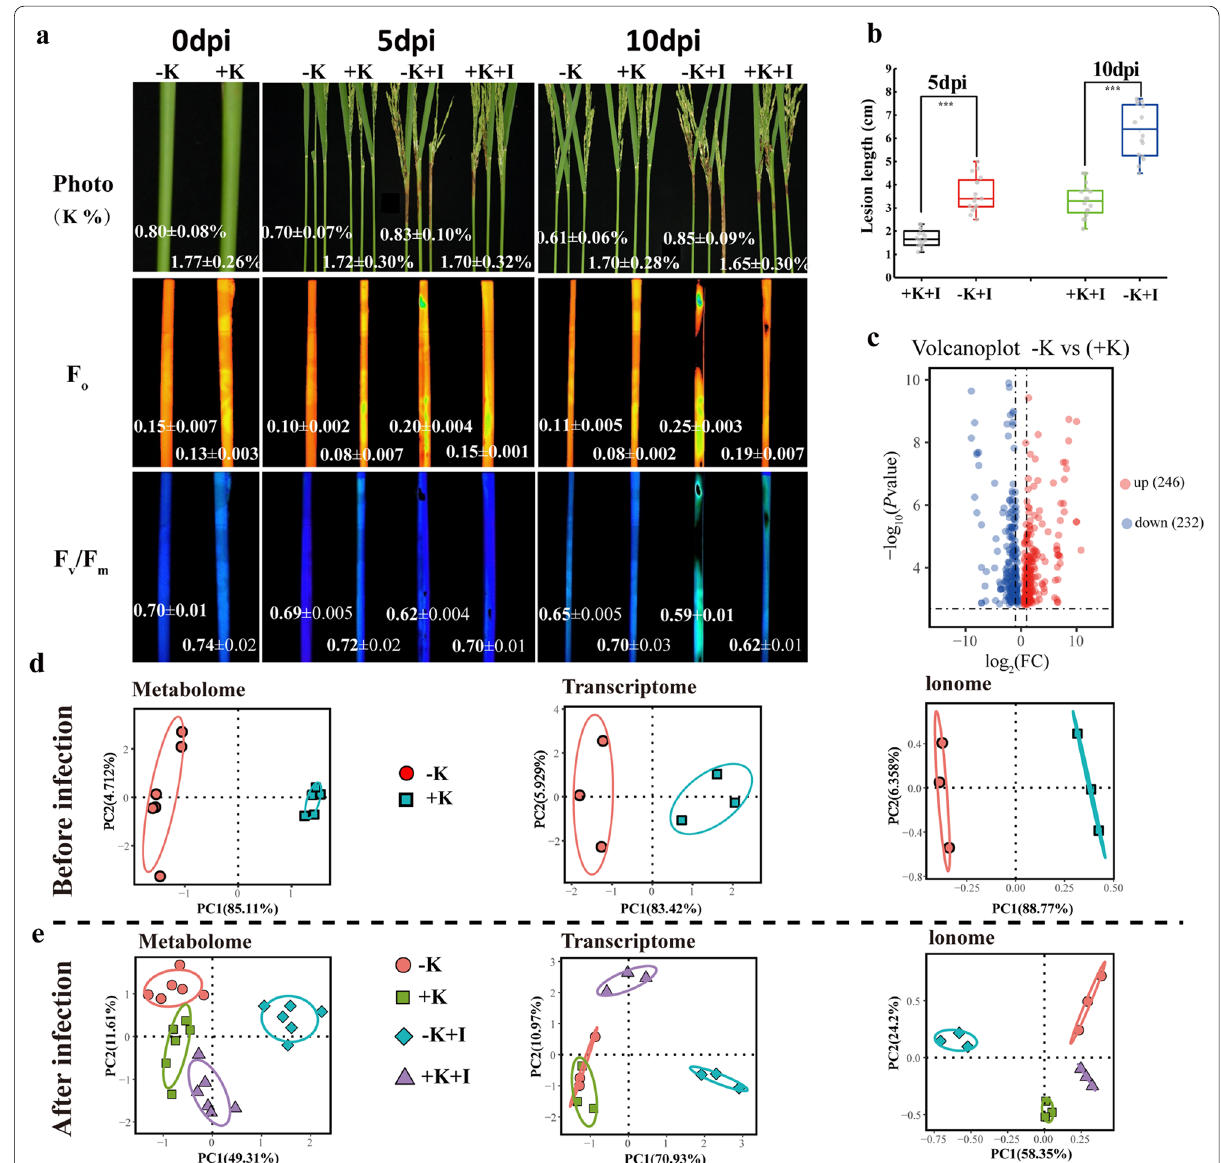
Fig. 1 Rice deficiency in K shows hypersensitivity to S. oryzae infection. a The typical symptoms of ShR disease and the development of ShR among different K nutrition conditions. Numbers in the picture represent K concentrations, F o and F v /F m values; dpi denotes days post inoculation; the abbreviations of the treatments, K represent potassium, “ ” and “ ” denote with or without K; I represent inoculation with S. oryzae . b Lesions + − + lengths (n 30 biologically independent tillers were selected for measurement, and five representative tillers were used for each replicate). c = Volcano plots showing the up- and down-regulated genes in K-starved plants versus K-sufficient plants before inoculation. d Principal component analysis (PCA) of K-starved and K-sufficient FLS based on the corresponding metabolome, transcriptome, and ionome datasets before S. oryzae inoculation. The metabolite relative intensity values (n 6 biological replicates), FPKM values for transcriptomes (n 3 biological replicates), = = and elemental contents (n 3 biological replicates) were used for PCA. e PCA of K-starved and K-sufficient FLS based on the corresponding = metabolome, transcriptome, and ionome datasets at 5 days upon S. oryzae inoculation. Biological replicates for each treatment are outlined by the